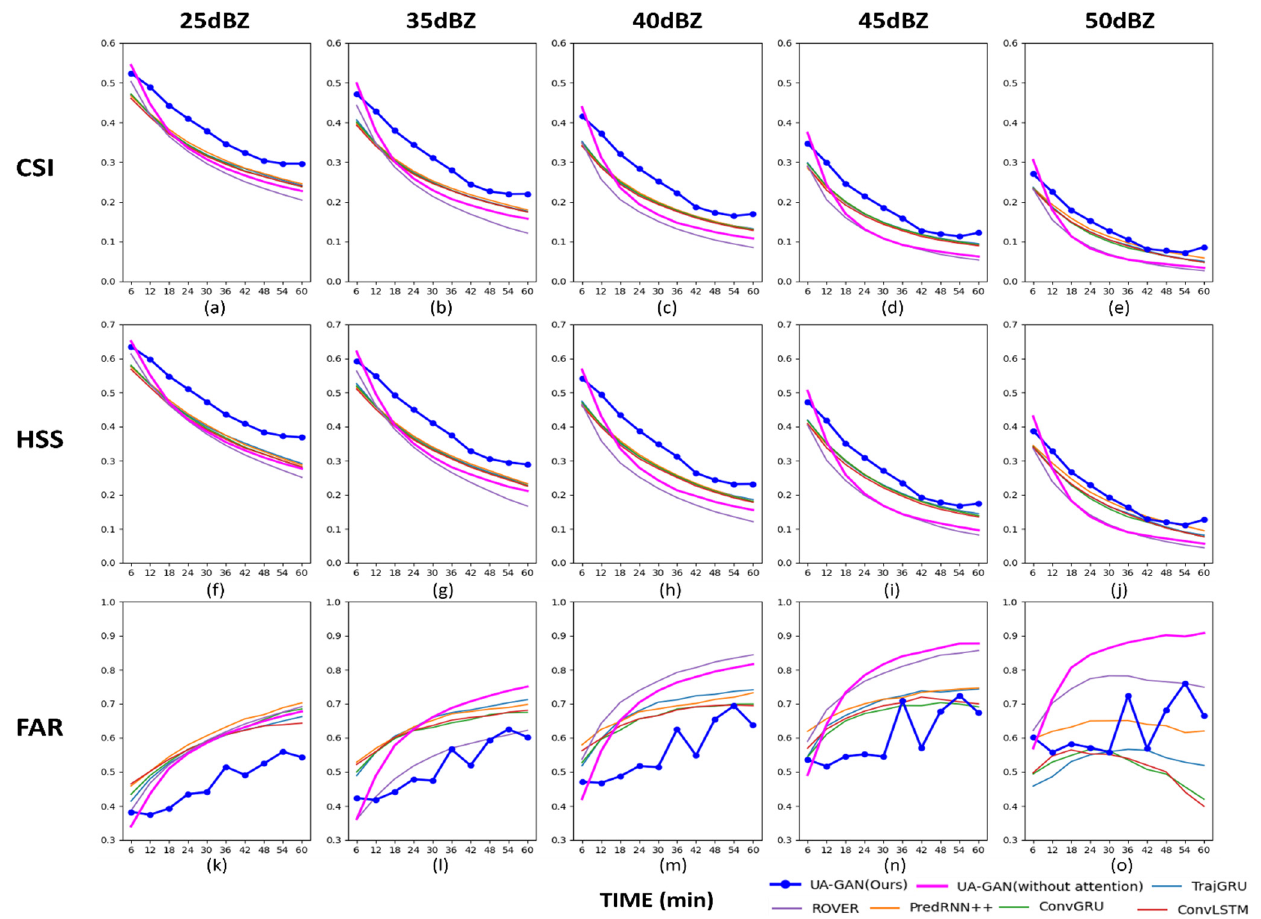
Figure 7. Subfigures ( a – o ) present the precipitation nowcasting evaluation scores (CSI, HSS, and FAR) for different lead times at different thresholds, respectively.